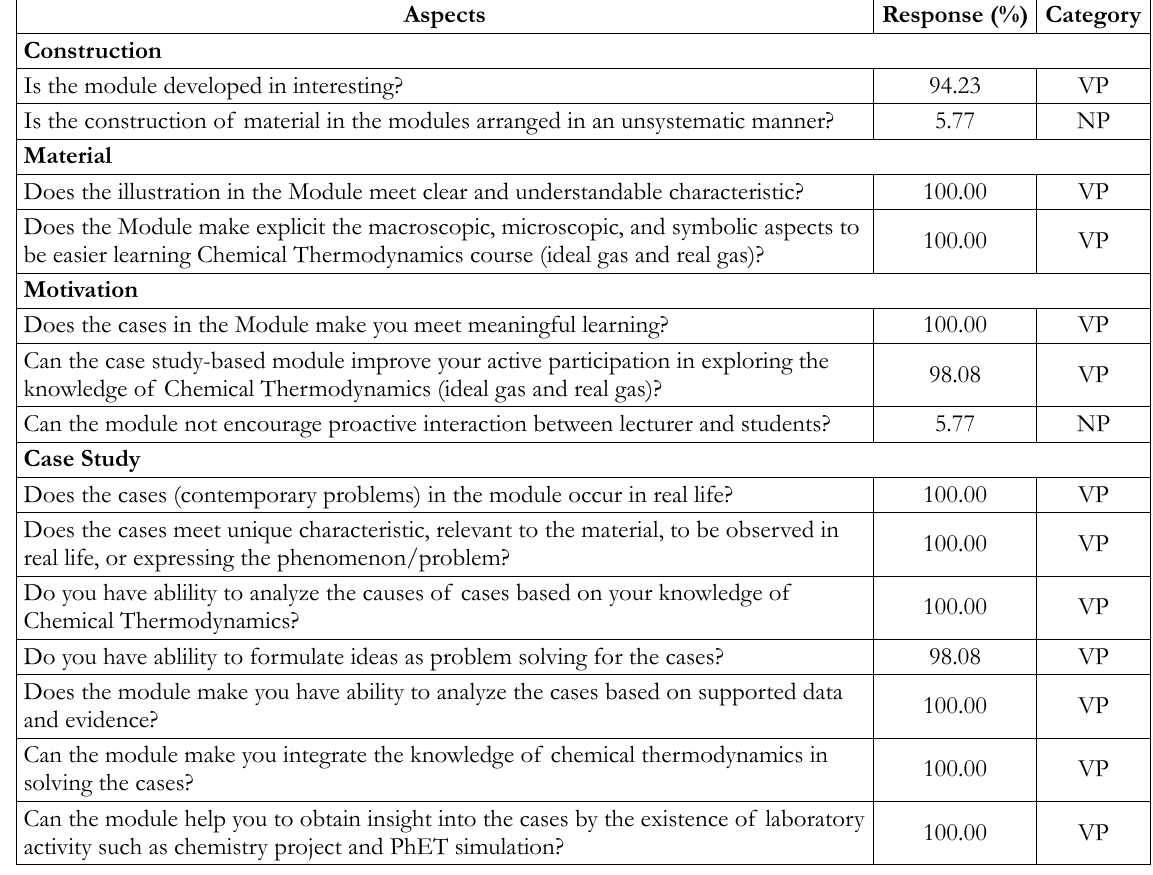
Table 6. The Questionnaire Results of Students’ Response in Very Positive (VP) up to Not Positive (NP)